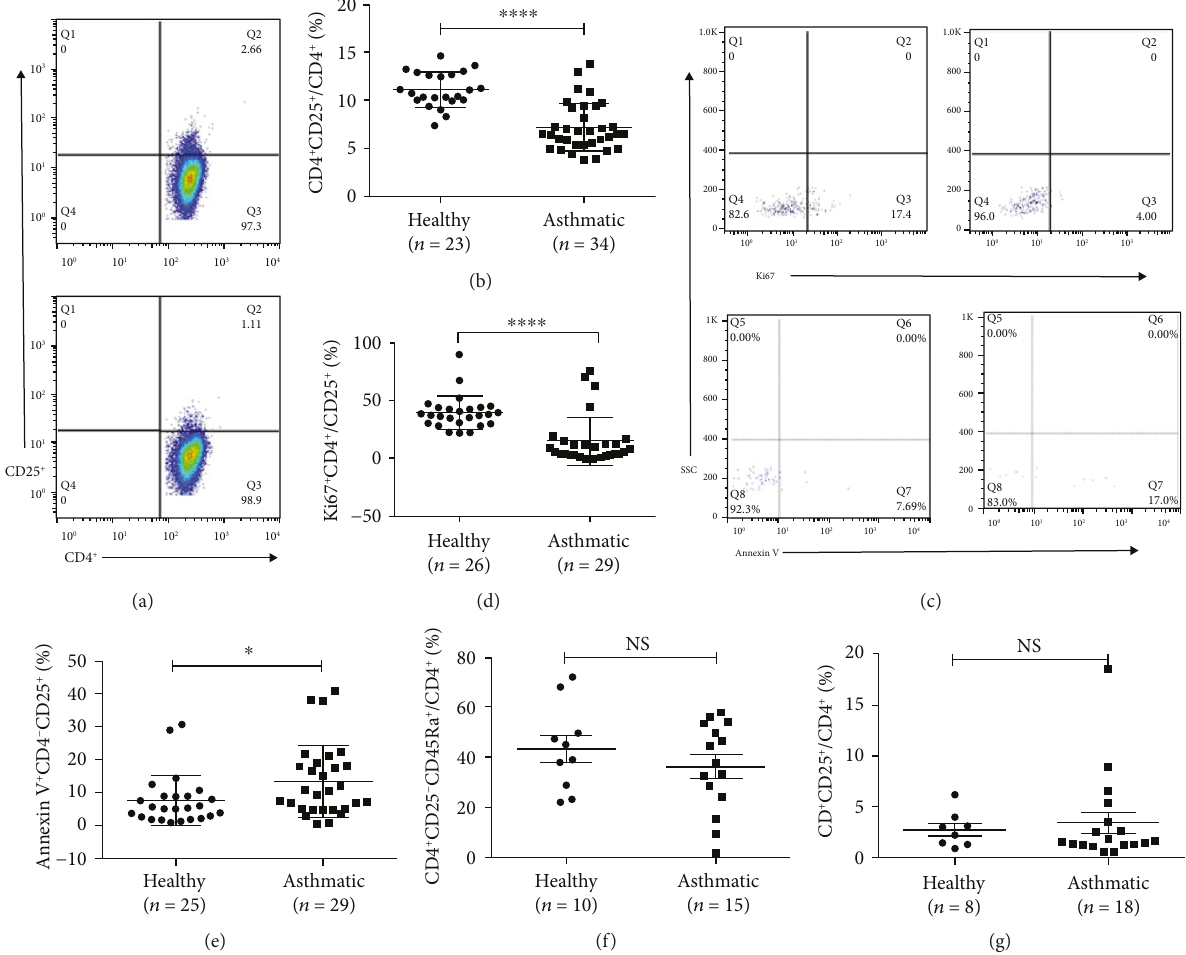
Figure 1: De fi ciency of Treg cells in patients with asthma. (a) Representative examples of fl ow cytometry analysis of CD4 + CD25 + Treg cells in healthy and asthmatic subjects. (b) Frequencies of CD4 + CD25 + Treg cells in CD4 + T cell subsets in healthy and asthmatic groups. (c) Representative examples of fl ow cytometry analysis of Ki67 + and Annexin V + cells of CD4 + CD25 + Treg cells in healthy and asthmatic subjects. (d) Frequencies of Ki67 and Annexin V (e) production in healthy and asthmatic subjects. (f) The percentage of CD4 + CD25 − CD45RA + T cells of CD4 + T cell subsets in healthy and asthmatic groups. (g) Percentage of Treg cells induced from naïve T cells of healthy and asthmatic groups in Treg cell polarity. The graph shows means ± sem . ∗ p < 0 05 and ∗∗∗∗ p < 0 0001 . NS: no signi fi